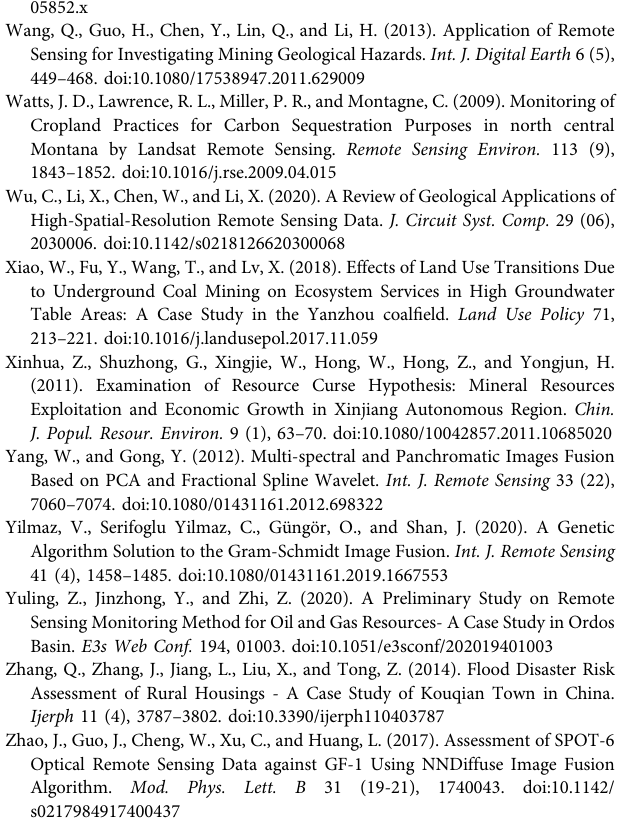
Table Areas: A Case Study in the Yanzhou coal fi eld. Land Use Policy 71, 213 – 221.